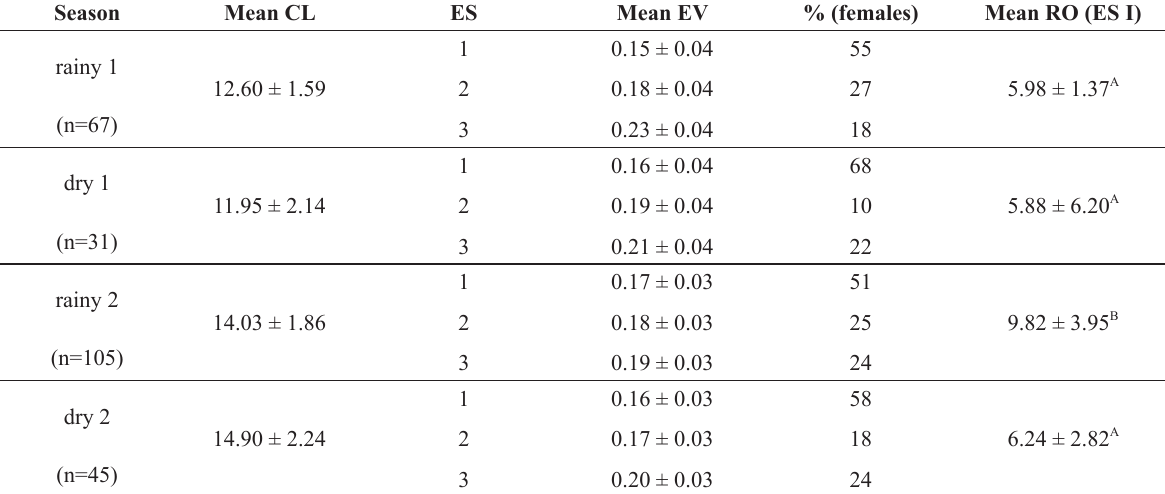
Variation in the mean egg volume (EV) by egg stage (ES) and reproductive output (RO) of Macrobrachium amazonicum (Heller, 1862), according to year seasons analyzed. Results expressed by Mean ± Standard deviation. Different letters represent significant